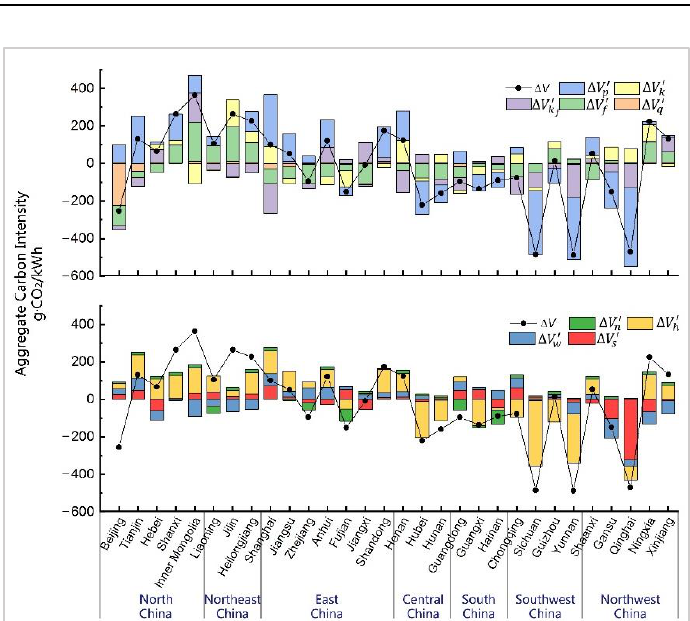
Figure 6. Performance of driving factors in spatial IDA-LMDI decomposition. Thermal efficiency and the thermal capacity factor also represented the important factors, contributing to the provincial ACI differences, despite Section 3.2 demonstrating that they had a negligible impact on ACI changes over the last five years. The thermal efficiencies of twelve provinces were higher than the national average, seven of which exceeded the national average by more than 10%: Inner Mongolia (+33.00%), Jilin (+30.66%), Ningxia (+17.16%), Heilongjiang (+16.83%), Liaoning (+15.21%), Shanxi (+14.61%), and Guizhou (+13.50%). In Inner Mongolia, the impact of thermal efficiency has pulled the ACI up by 209.17 g · CO 2 /kWh relative to the national average. In Jilin, this impact reached 184.80 g · CO 2 /kWh. The thermal capacity factor analysis demonstrated that there were thir- teen provinces with a thermal capacity factor higher than that of the national average, six of which exceeded the national average by more than 10%: Inner Mongolia (+23.32%), Jiangxi (20.55%), Anhui (+13.40%), Xinjiang (+12.57%), Hebei (+11.56%), and Hubei (+10.84%). In Inner Mongolia, the thermal capacity factor induced an ACI increase of 153.74 g · CO 2 /kWh. By contrast, in the provinces with a lower thermal capacity factor, such as Shanghai